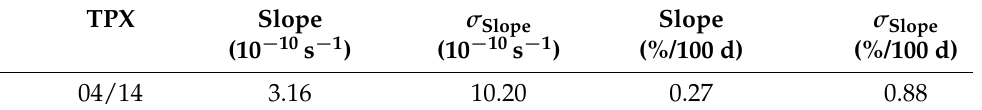
Slope of time history of the luminosity ratio measured by TPX04 and TPX14. The measurements are averaged over the data recorded by layers 1 and 2. The slope values and the uncertainties are given per second and in percent per 100 days. Taken from Ref. [17].